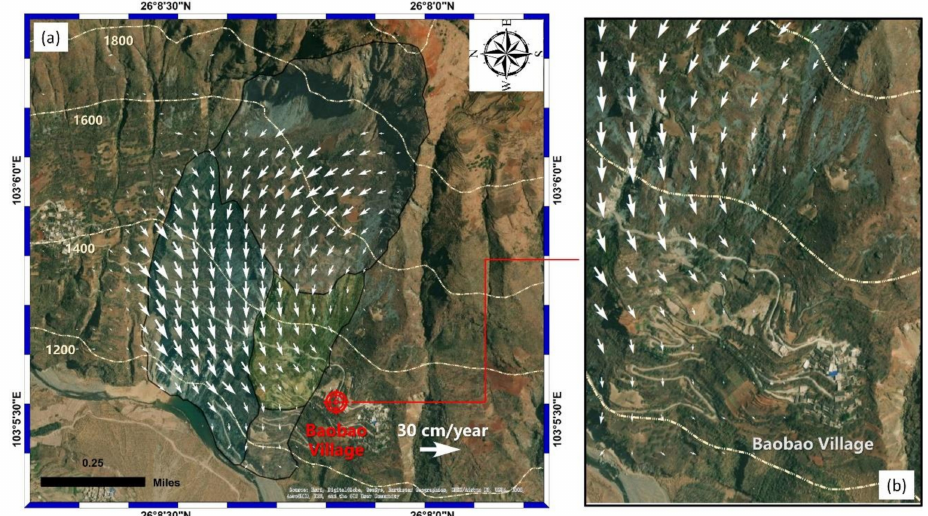
Figure 9. ( a ) Horizontal movement vectors of the Baobao landslide and ( b ) the enlarged horizontal movement vector over the Baobao Village. The base map is the optimal image acquired on April 2019.